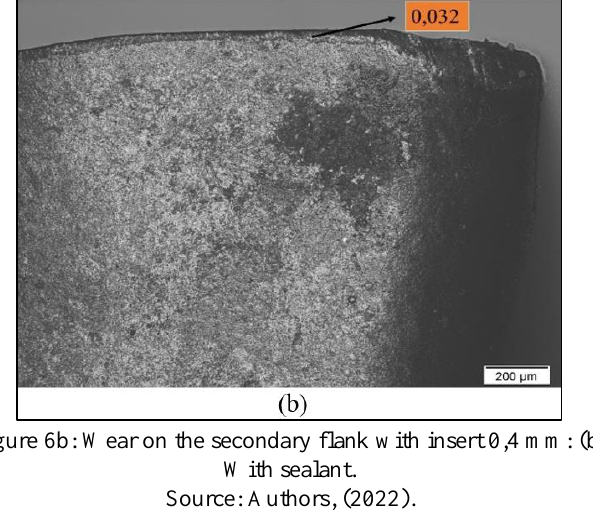
Figure 8a: Wear on the cutting tool rake face with insert 0,4 mm: (a) Without sealant.